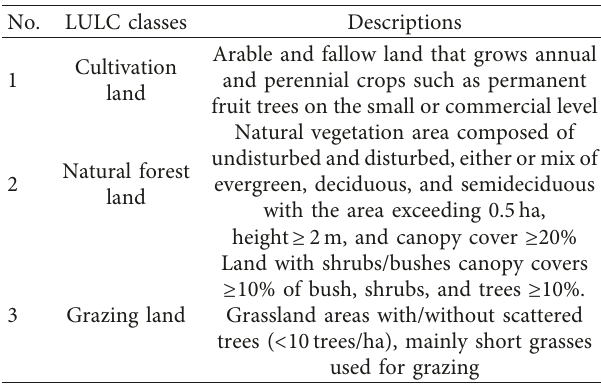
Figure 1: Study map of the Geshy subcatchment, Gojeb River Catchment, Ethiopia. Table 1: Land uses description in the Geshy subcatchment,